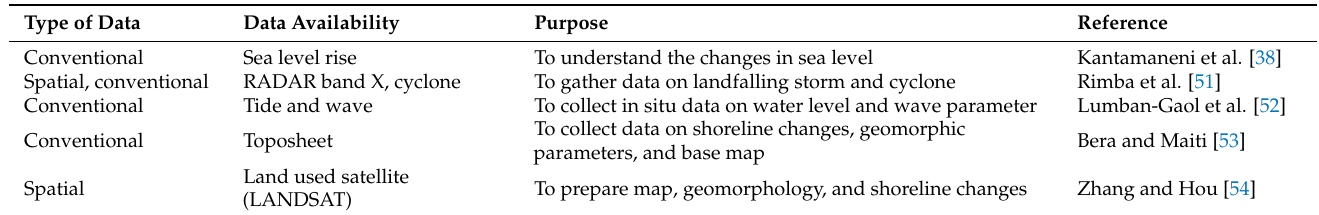
Table 3. Common types of data and their availability for assessing coastal vulnerability in Southeast